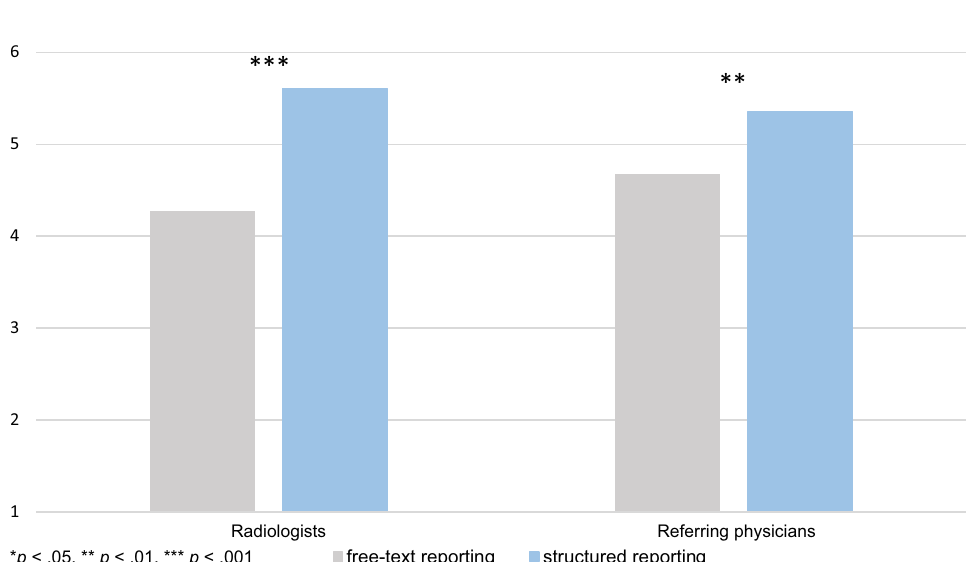
Fig. 6 Satisfaction of referring physicians with SR and FTR predicted by radiologists (left) and self-reported satisfaction of referring physicians with SR and FTR